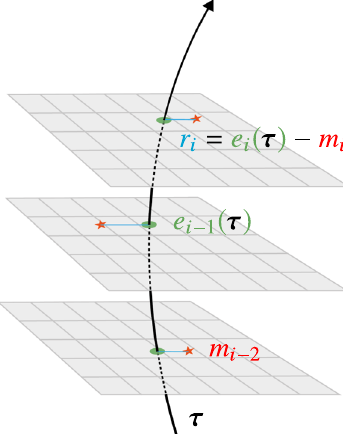
Fig. 3 Schematicrepresentationofachargedparticlecrossingdetector planes. The measurement, m i , on each the i th layer is indicated by a red star. Also shown are the fitted track trajectory for a given set of track parameters, τ (black line), the position of the intersection of the fitted track with the surface on which the i th measurement is made, e i ( τ ) (green ellipse), and the residuals, r i (blue